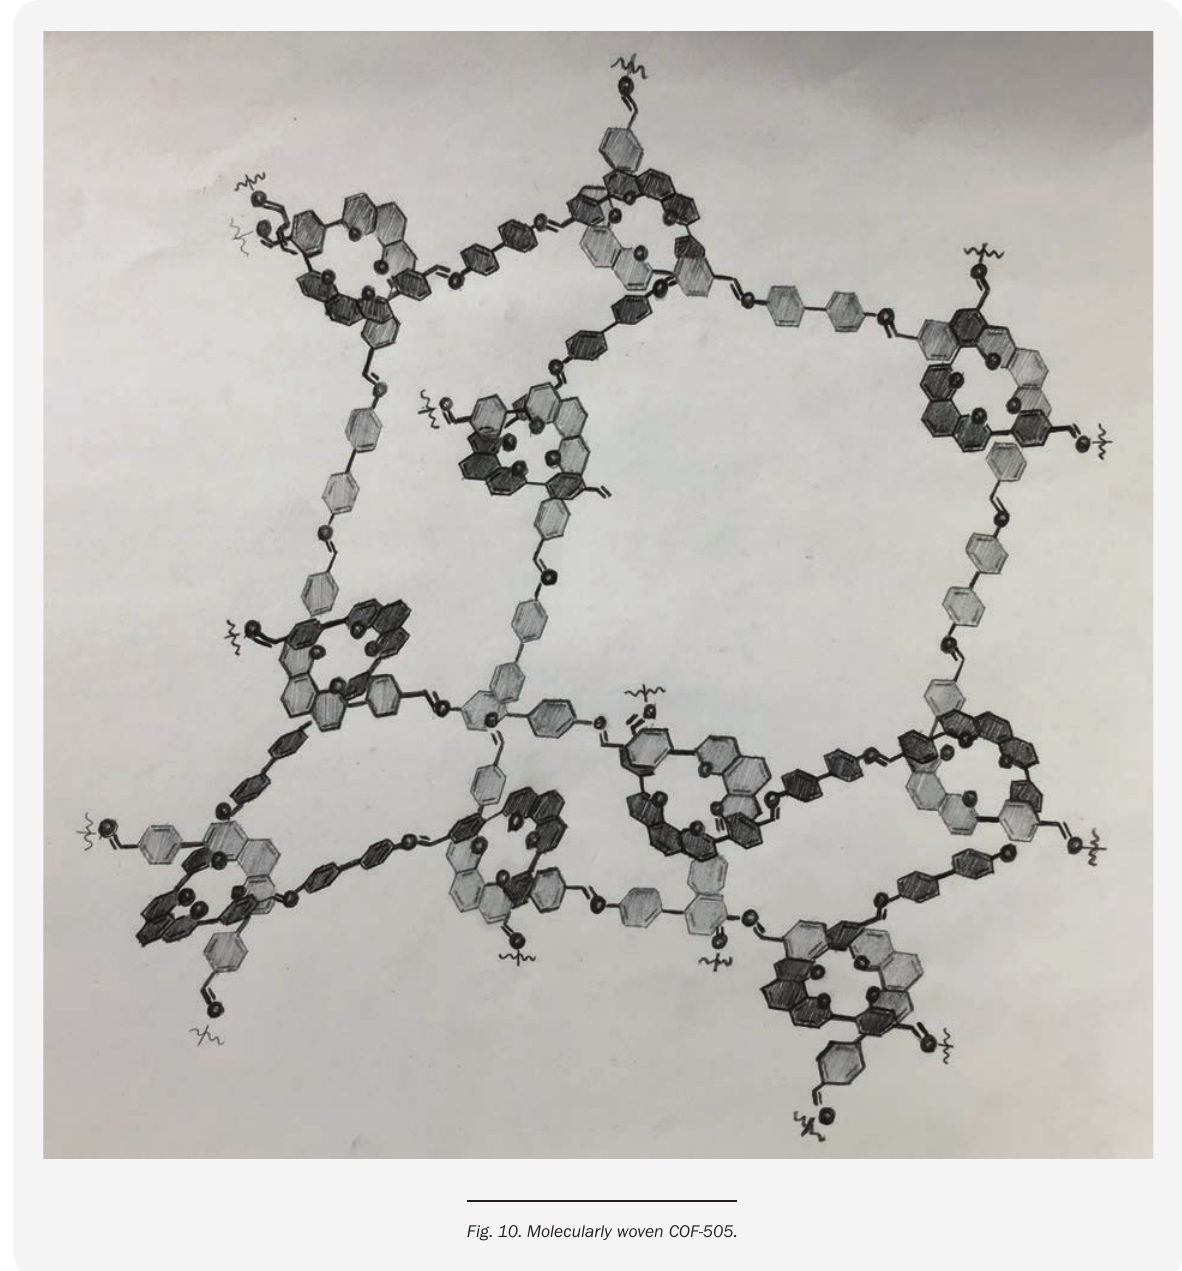
Fig. 10. Molecularly woven